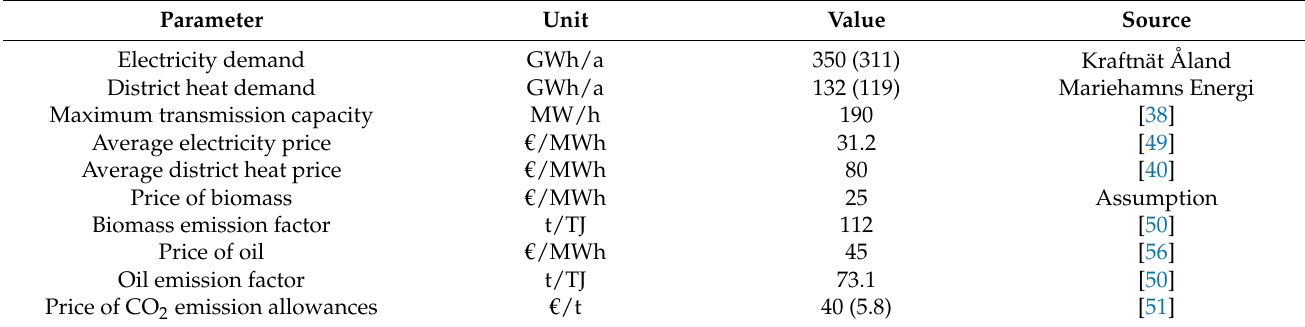
Table 2. Techno-economic parameters assumed for the scenarios. Values used in the Base scenario are shown in brackets.